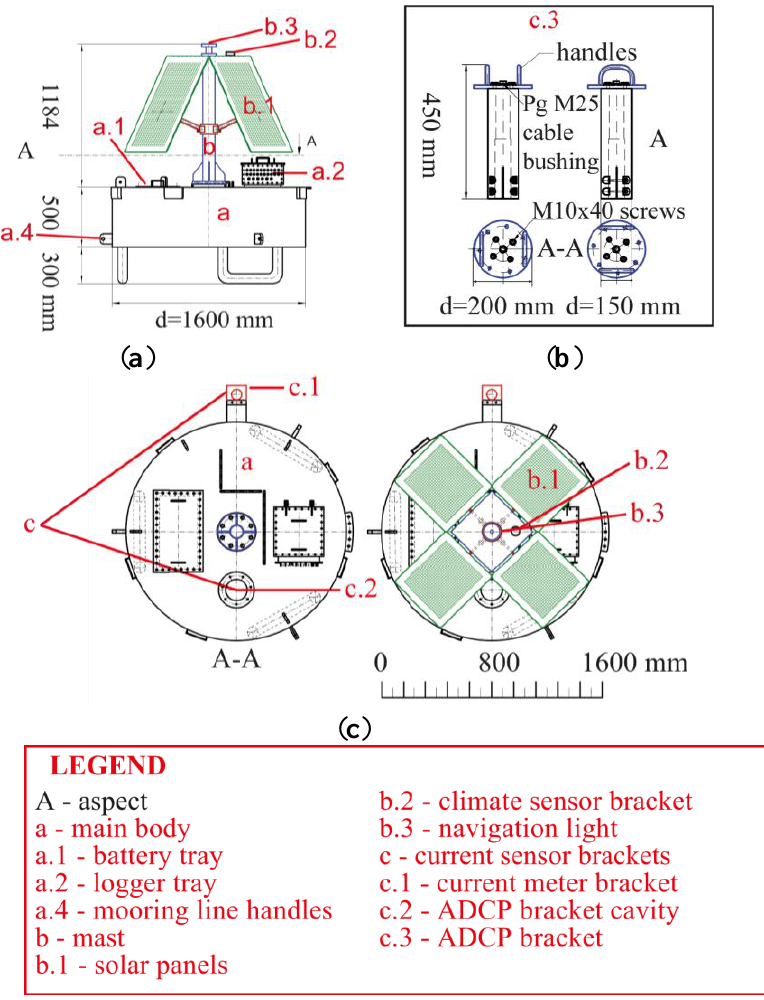
Figure 1. Technical drawing of the buoy. ( a ) The side view, ( b,c ) The top view of the main body and the entire buoy. The measurement chain is not illustrated. It is attached to the center of the bottom side of the main body.